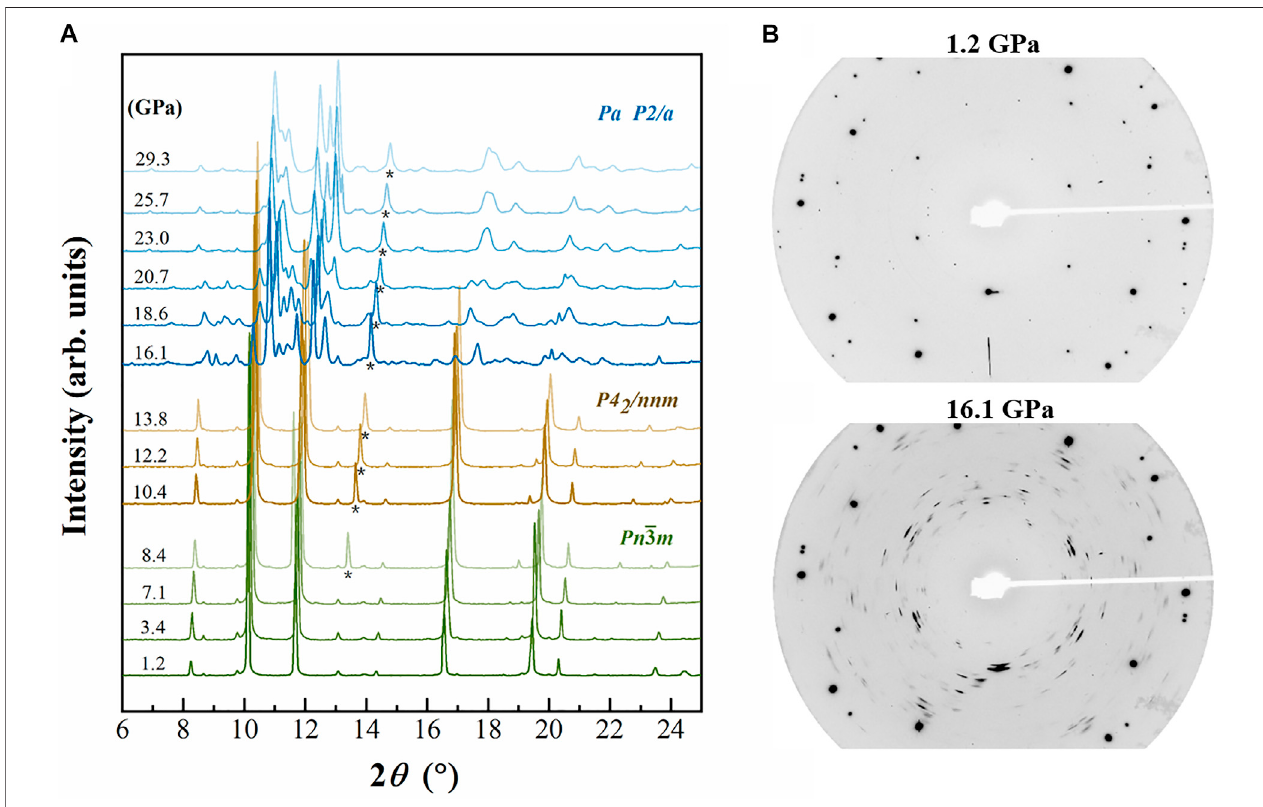
FIGURE 1 | (A) Integrated XRD patterns of Cu 2 O at elevated pressures. Backgrounds were subtracted from the origin data. Asterisk (*) represents the scattering peaks of neon. (B) Diffraction patterns of Cu 2 O at 1.2 and 13.8 GPa, respectively. The very intense diffraction spots are from the diamond anvils. Diamond peaks and diffraction lines attributed to the neon are not